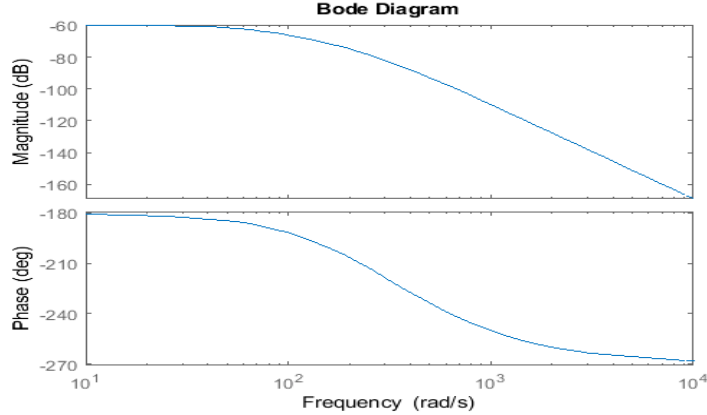
7 of 17 Figure 5. Block diagram representation of the state feedback control system with state estimator. Analysis From the characteristic equation of the AMB plant model, it is observed that the plant is unstable with a pole at 91.9 rad/s in the y -plane. In this study frequency response method is employed for the analysis and design of the controller. From Figure 6, it can be seen that at the corner frequency, the gain is less than 0 dB with a phase delay of fewer than − 180 degrees thus the AMB system is unstable. The compensator is designed for the stable functioning of the AMB system with desired performance specifications the Loop transfer function 𝐿(𝑠) is utilized. 𝐿(𝑠) = 𝐺 (cid:3004) (𝑠) 𝐺 (cid:3028) (𝑠) 𝐺 (cid:3032)(cid:3039)(cid:3032)(cid:3030)(cid:3047)(cid:3045)(cid:3036)(cid:3030)(cid:3028)(cid:3039) (𝑠)𝐺 (cid:3040)(cid:3032)(cid:3030)(cid:3035)(cid:3028)(cid:3041)(cid:3036)(cid:3030)(cid:3028)(cid:3039) (𝑠) 𝐺 (cid:3046) (𝑠)